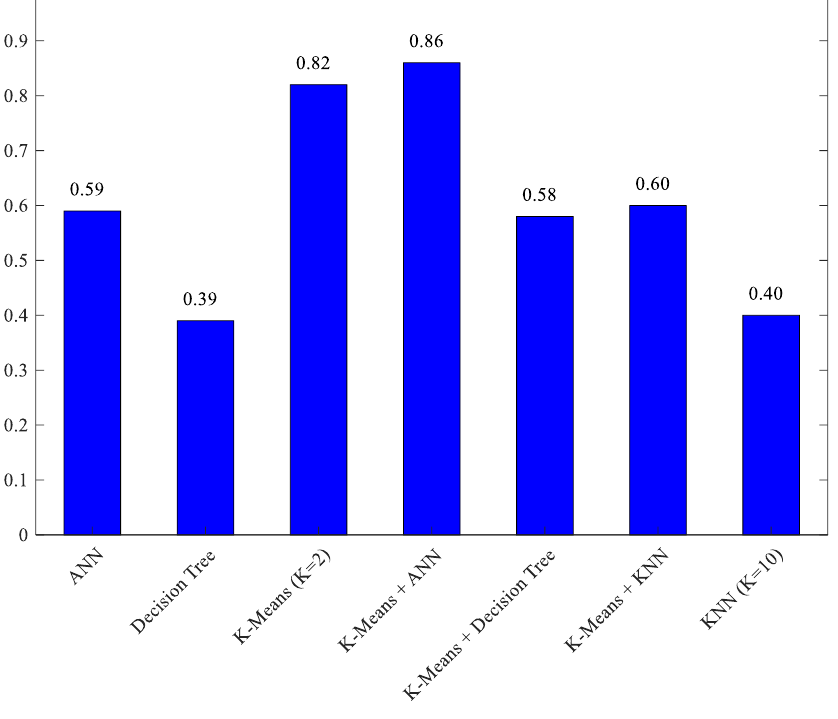
Figure 8. AUC for all classifying